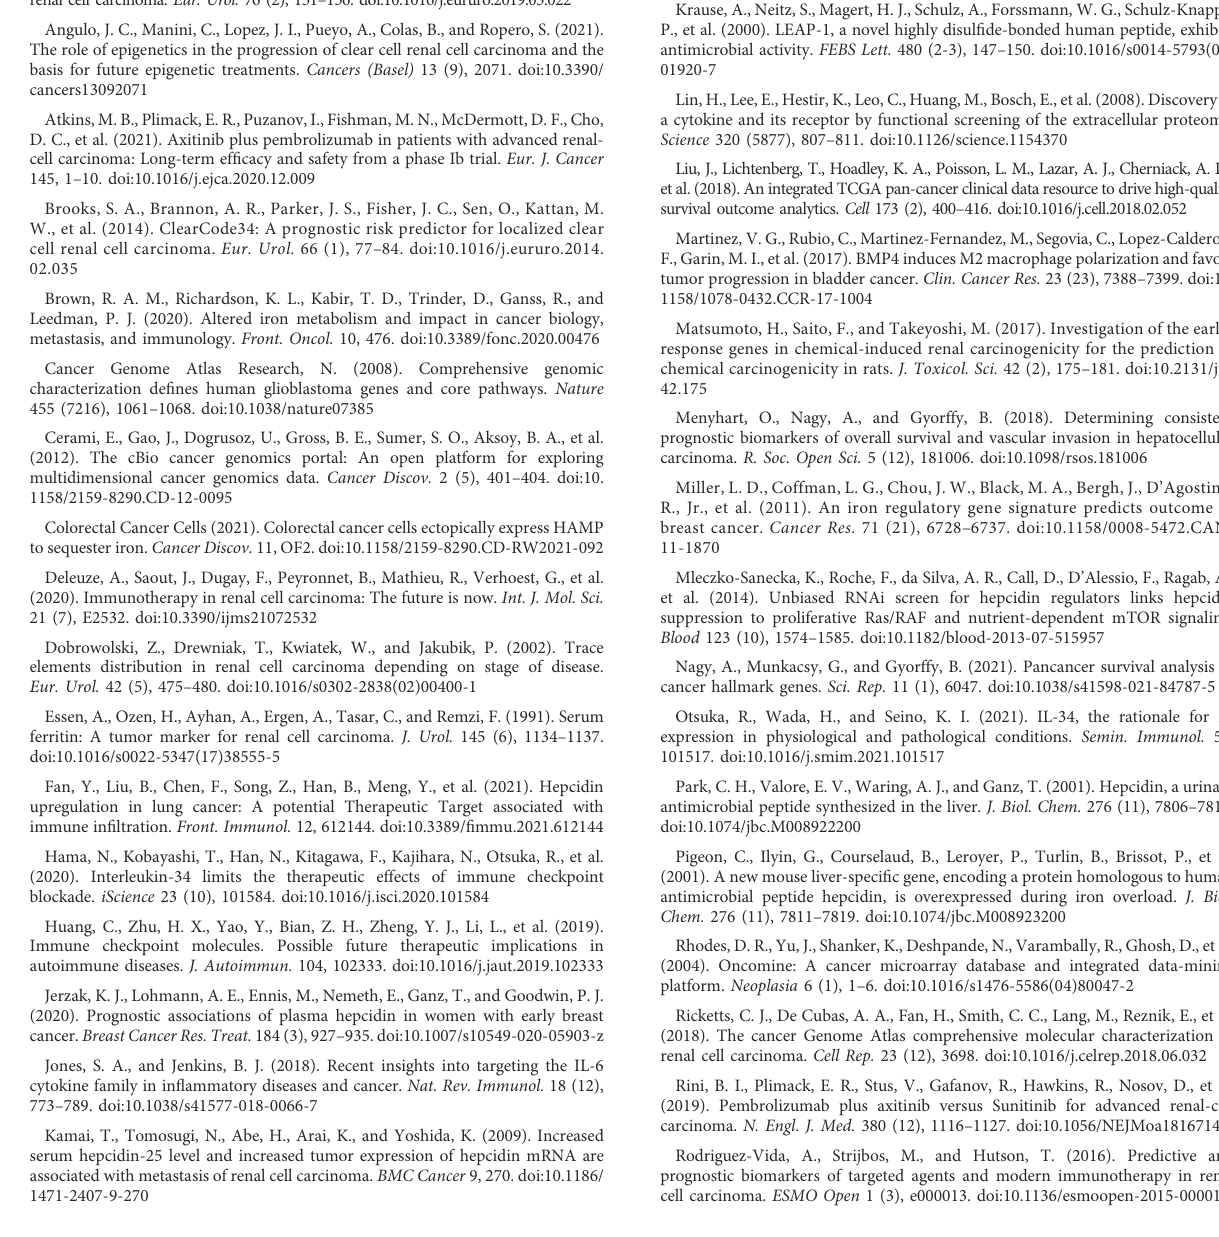
SUPPLEMENTARY TABLE S1 Relationshipofiron-modulatinggeneswithclinicopathologicalparameters in ccRCC patients. Footnotes: Gene expression comparisons between